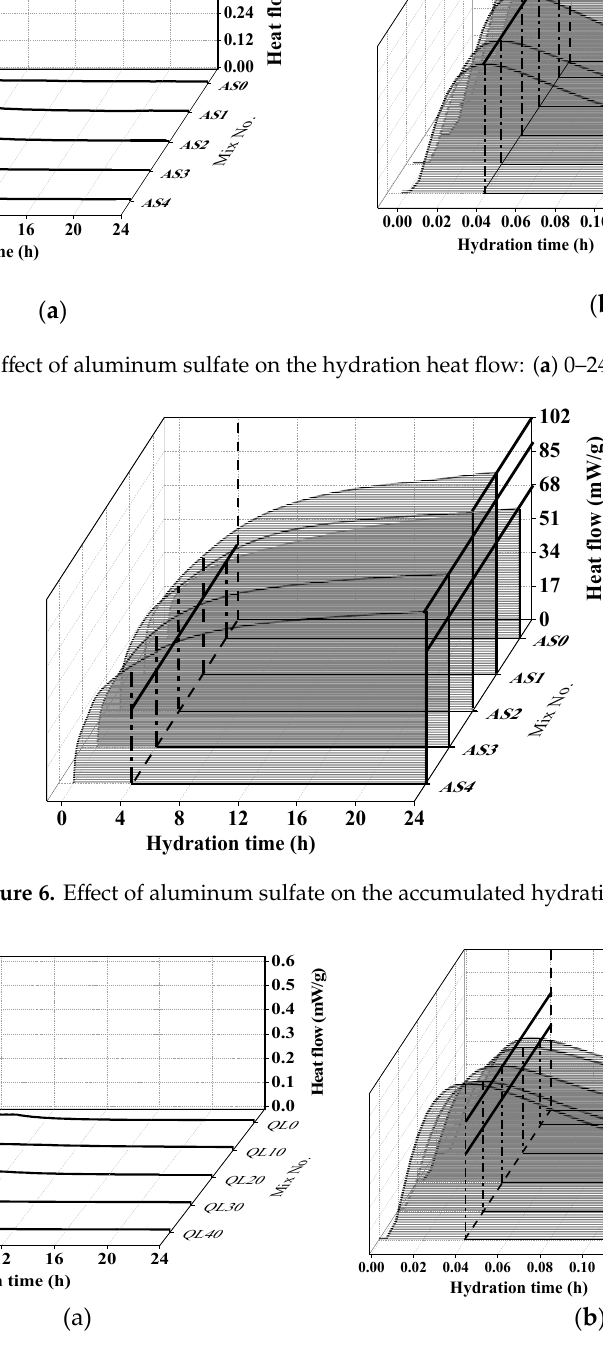
Figure 7. Effect of quicklime on the hydration heat flow: ( a ) 0–24 h, ( b ) 0–0.14 h.